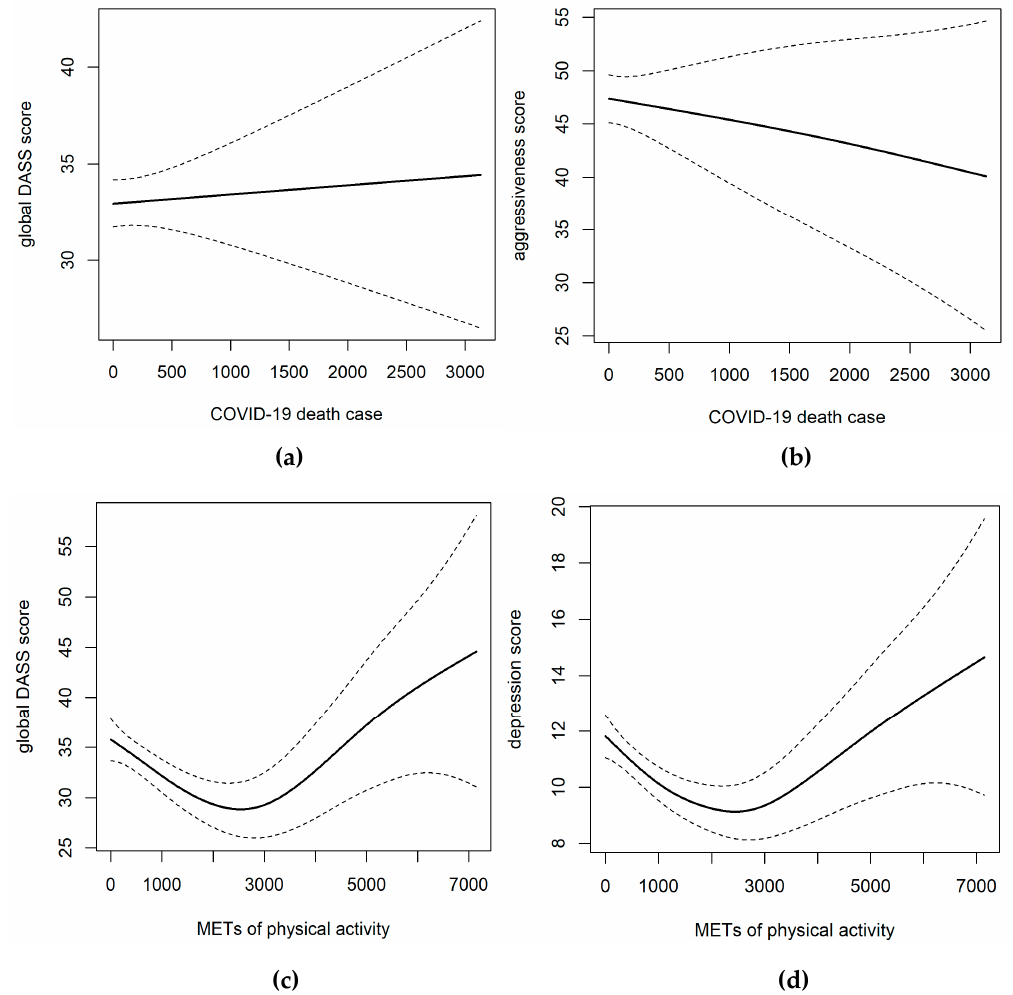
Figure 4. Relationship between COVID-19 deaths, physical activity and negative emotions, and aggressiveness. Note: The subgraph of ( a – d ) indicates the relationship between the COVID-19 and global negative emotions, the COVID-19 and aggressiveness, physical activity and global negative emotions, physical activity and depression, respectively. Splines for either the COVID-19 death count or energy expenditure in MET-minutes per week (METs) of physical activity were entered into a mixed-e ff ect model with random e ff ects on individuals. Dashed lines indicate 95% confidence intervals. The global DASS score ranges from 0 to 63, where a larger value means increased negative emotions; depression scores range from 0 to 21, with larger values indicating more depressive emotions; and aggressiveness scores range from 22 to 110, with larger values indicating more potentially aggressive behaviour.